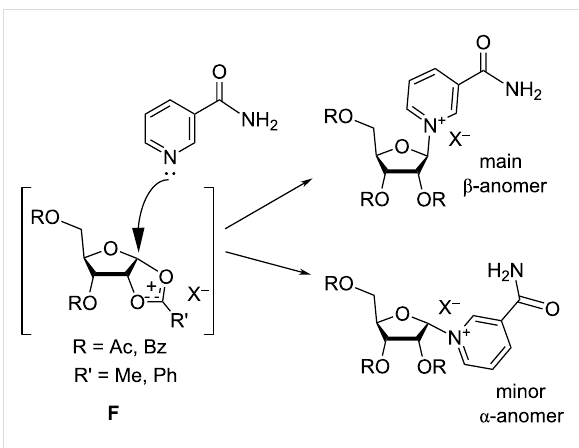
Jarman et al. [22] demonstrated that NR + Cl − may be prepared from the partially protected crystalline 3,5-di- O -benzoyl-D- ribofuranosyl chloride ( 5 ). Unfortunately, the anomeric α / β ratio was not reported. Once 3,5-di- O